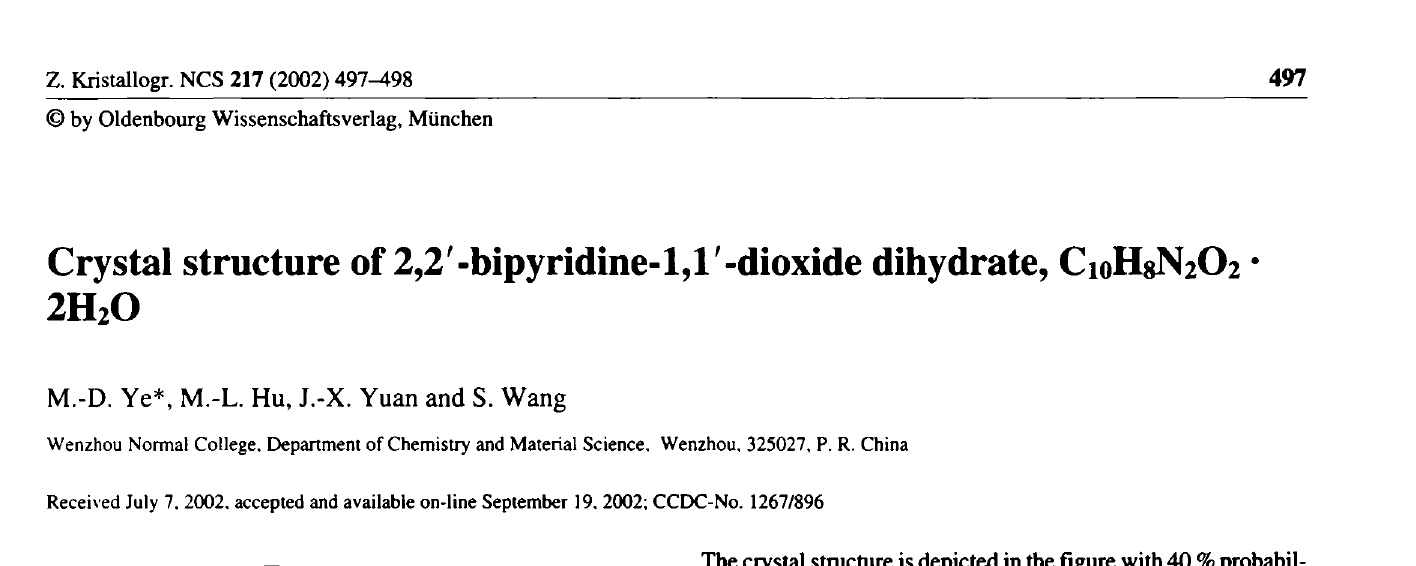
Table 1. Data collection and handling.